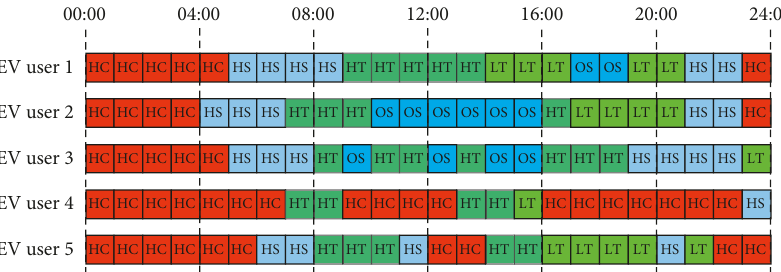
Figure 5: Randomly selected state sequences of five EVs with a time window of